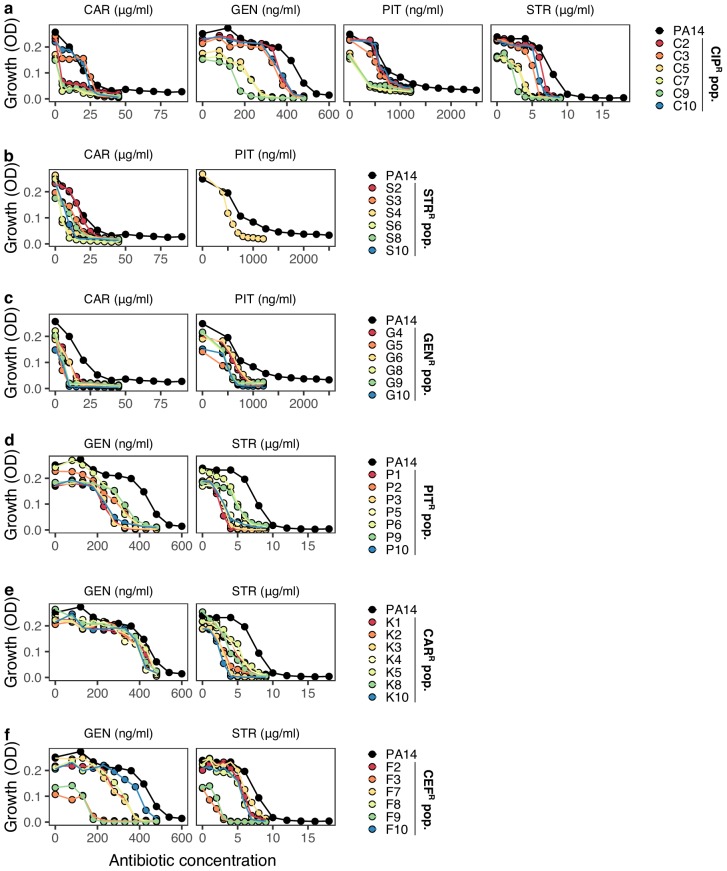
Collateral sensitivity.Validated collateral sensitivity for 38 distinct populations obtained from Barbosa et al. (2017). Six to seven populations resistant to CIP, (a); STR, (b); GEN, (c); PIT, (d); CAR, (e); and CEF, (f), were tested for collaterals sensitivity against 2 or four drugs, indicated above each of the panels. The ancestor PA14 is shown in black and the various populations in distinct colors. Points indicate averages of 3 technical replicates per population and drug concentration. CAR, carbenicillin; GEN, gentamicin; STR, streptomycin; PIT, piperacillin with tazobactam; CIP, ciprofloxacin; and CEF, cefsulodin; superscript R denotes resistance against the particular drug. The data for this figure is provided in Figure 5—figure supplement 1—source data 1.Figure 5—figure supplement 1—source data 1.Dose-response curves data of surviving populations in the generalized experiment.The data is shown in Figure 5—figure supplement 1 and summarized in Figure 5. Optical density values were recorded after 12 hr of incubation at 37 °C.